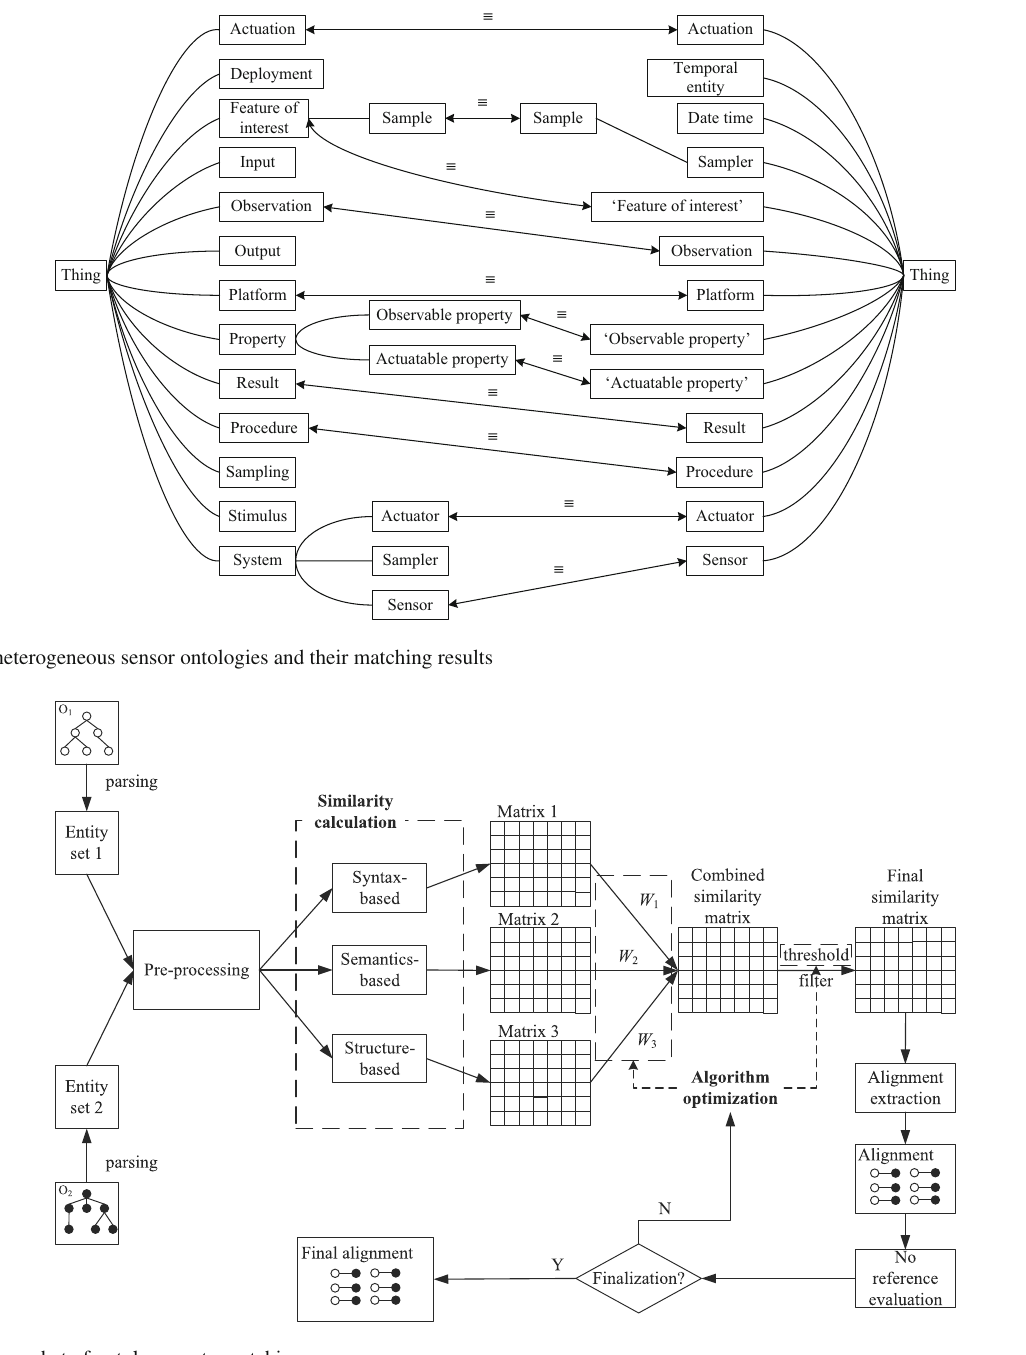
harmonic average f-measure [51]. For different users, the importance of different evaluation metrics is also